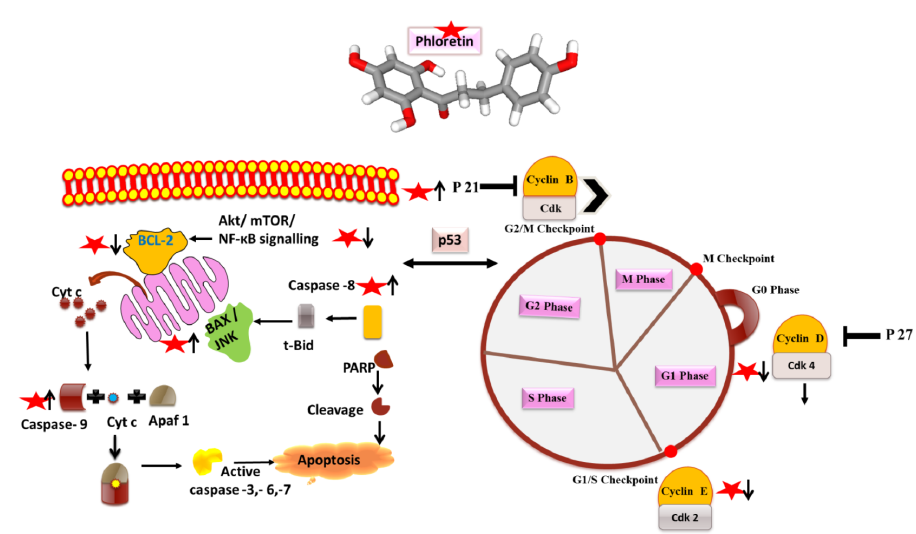
Figure 5. Phloretin (as red star) and its mode of action on apoptosis and cell cycle arrest molecules. Arrows designate up ( ↑ ) and downregulation ( ↓ ) of the